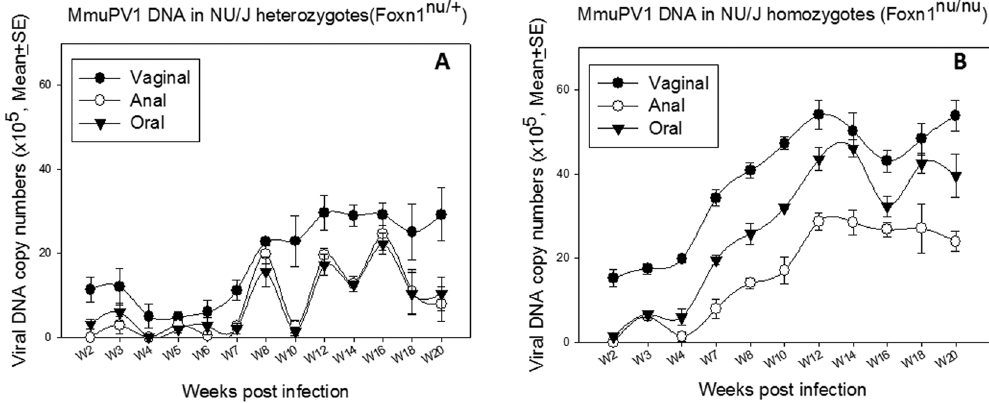
Figure 3. Persistent mucosal infection was established in the immunocompetent NU/J heterozygous mice. Four homozygous inbred NU/J nude mice ( A ) and four inbred heterozygotes ( B ) were tested for infection at mucosal sites. Viral DNA was monitored periodically over the infection course at the mucosal sites (the vagina, the anus and the oral cavity). Both strains supported persistent infections. Significantly higher viral DNA copy numbers were detected in the homozygous nude mice (P < 0.001, after week seven post infection, unpaired student T